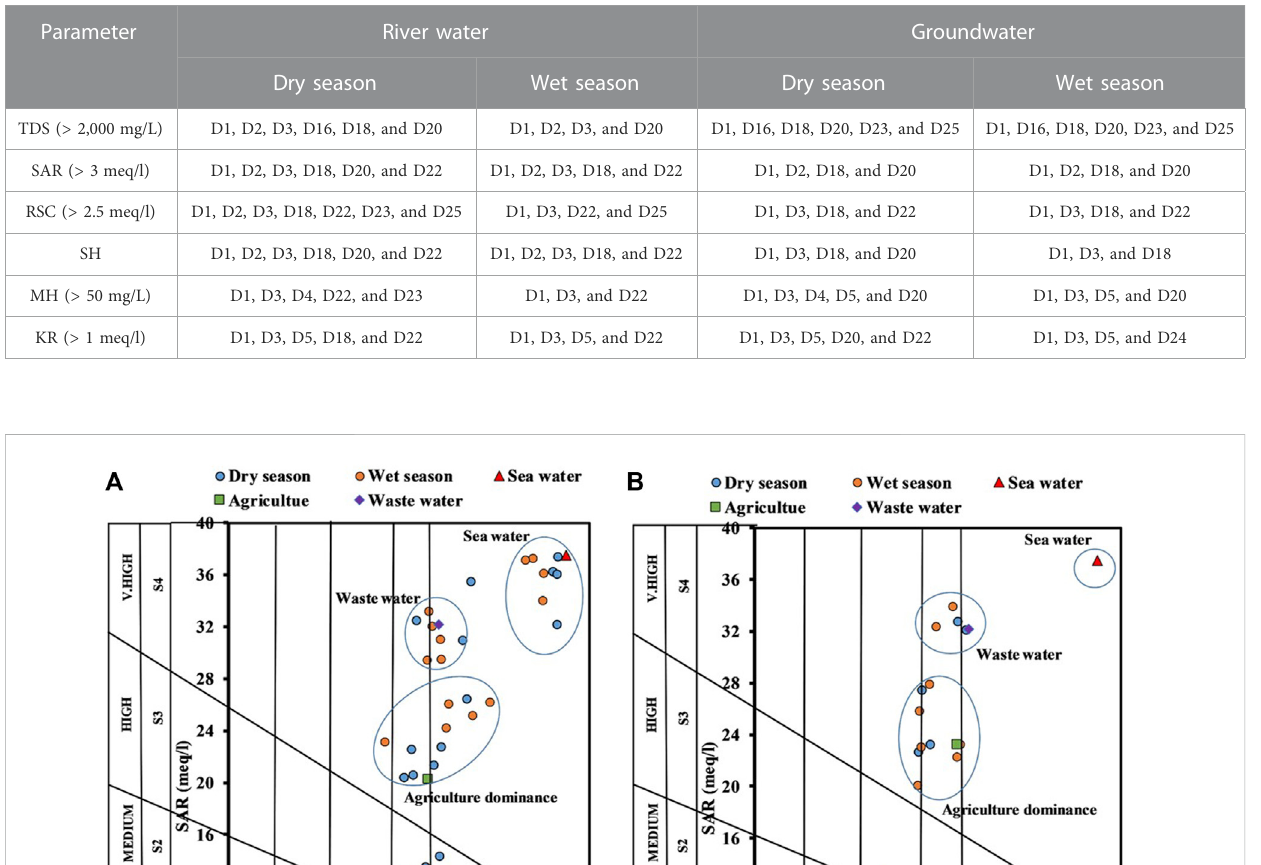
TABLE 2 Irrigation water quality unsuitable locations.